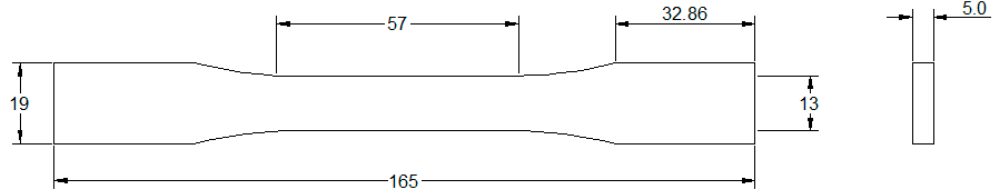
Figure 1. Dimensions of the standard tensile specimen [31].